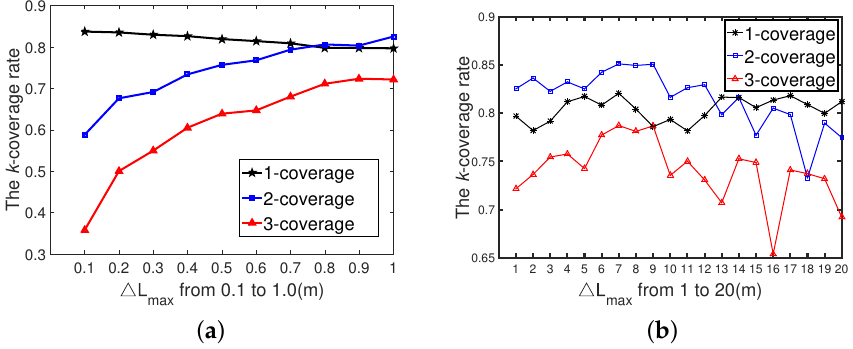
Figure 12. The correlation between ∆ L max and the k -coverage rate. ( a ) The correlation between ∆ L max and the k -coverage rate ( n = 400, r = 10 m, ∆ L max = 0.1 ∼ 1 m) ; ( b ) The correlation between ∆ L max